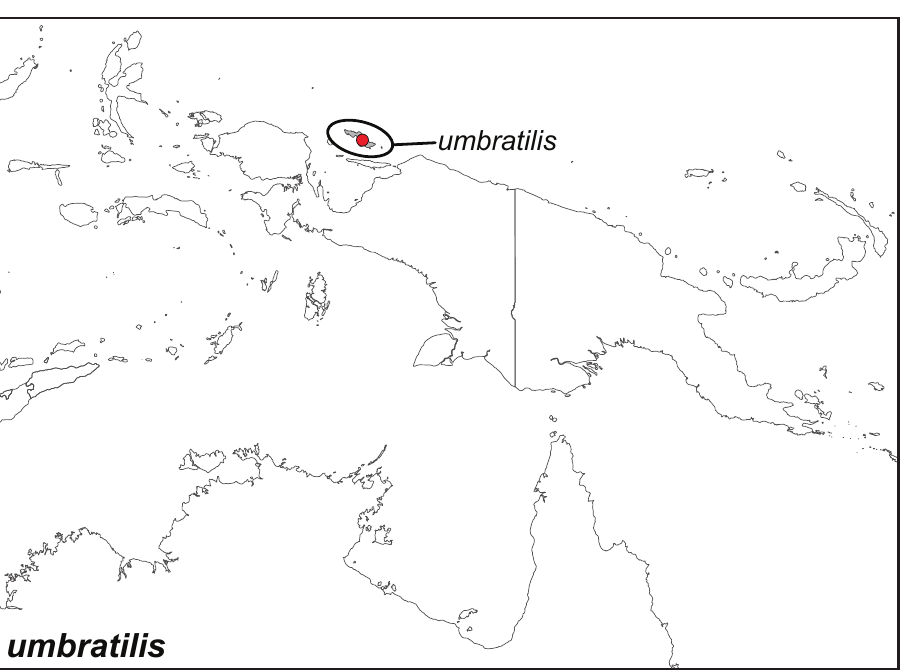
Figure 76. Distribution map of Elymnias umbratilis